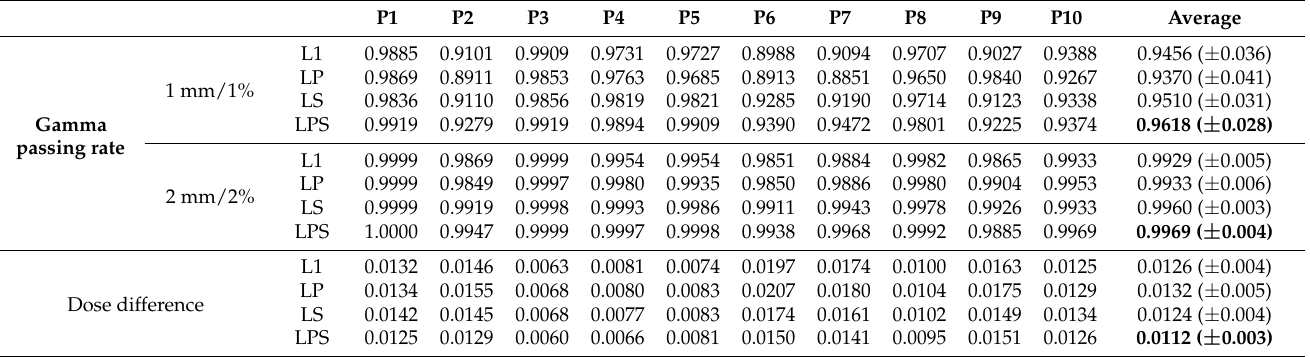
Table 3. Gamma passing rate and dose difference analysis on CBCT and DL output by different learning losses compared with dose distribution on deformed CT for the 10 test set. P1 P2